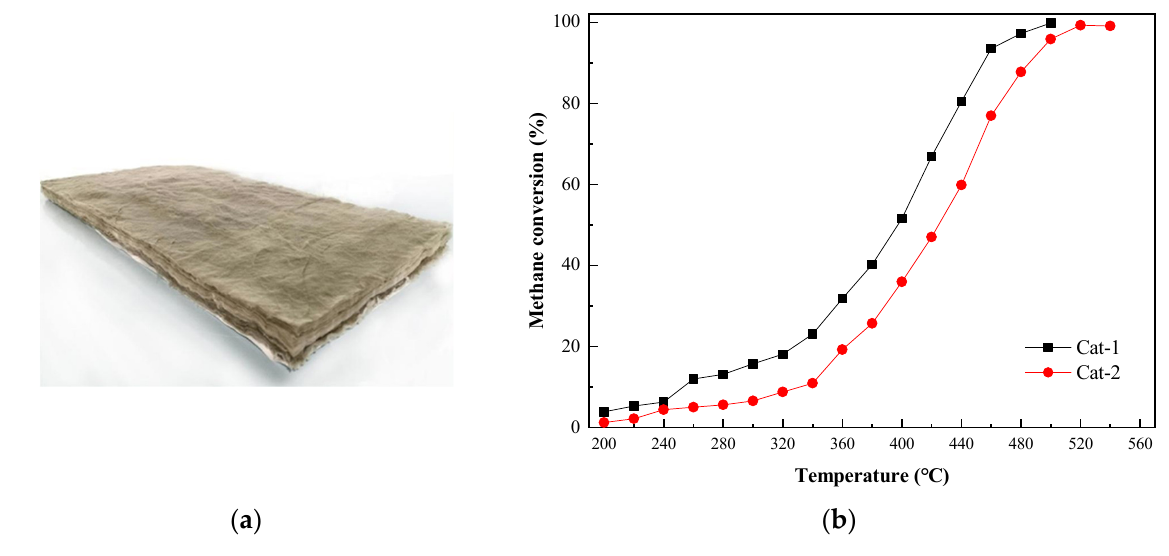
Figure 4. ( a ) Fiber ‐ supported noble metal catalyst. ( b ) Methane conversion versus temperature with the Cat ‐ 1 and Cat ‐ 2 catalysts. Table 2. Physical properties of fiber ‐ supported noble metal catalyst (Cat ‐ 1).